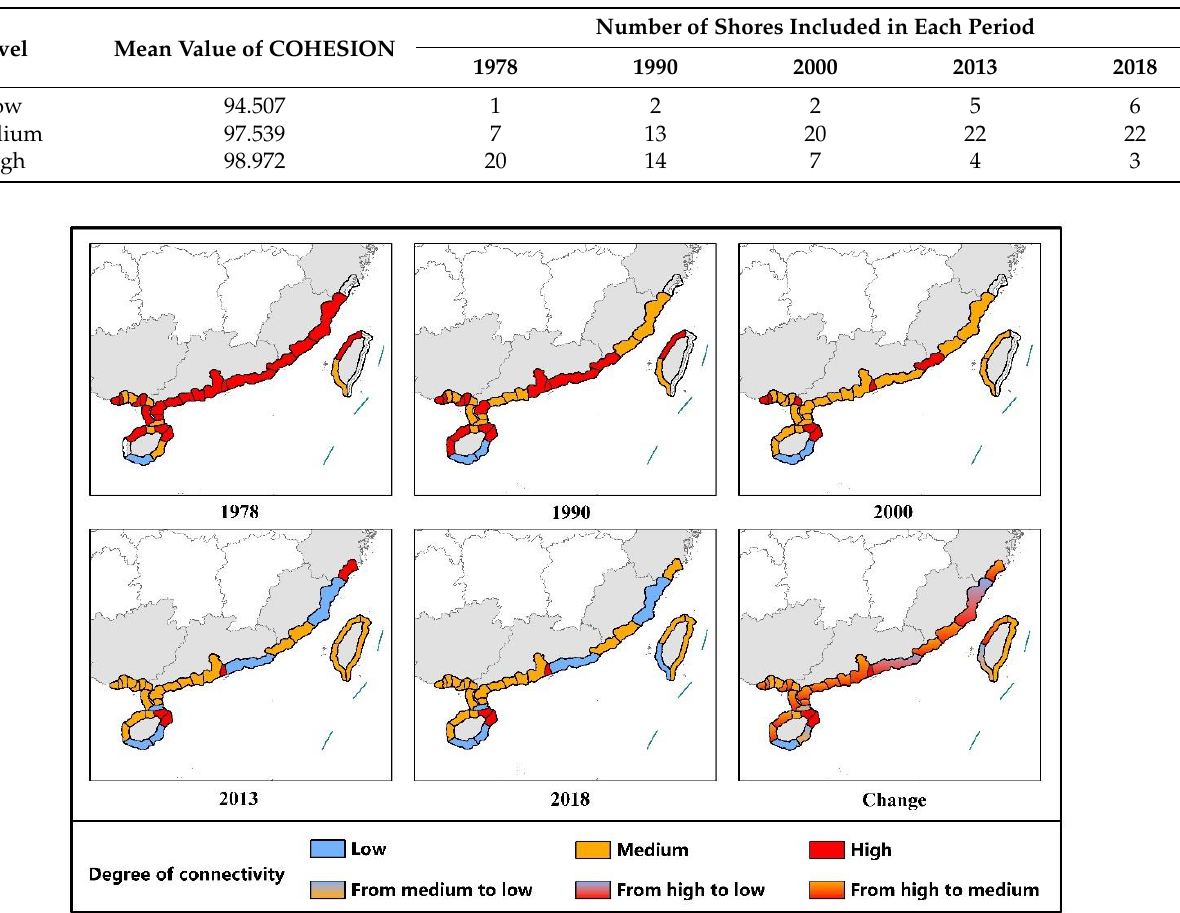
Table 8. Change in the level of the connectivity and the number of included shores.